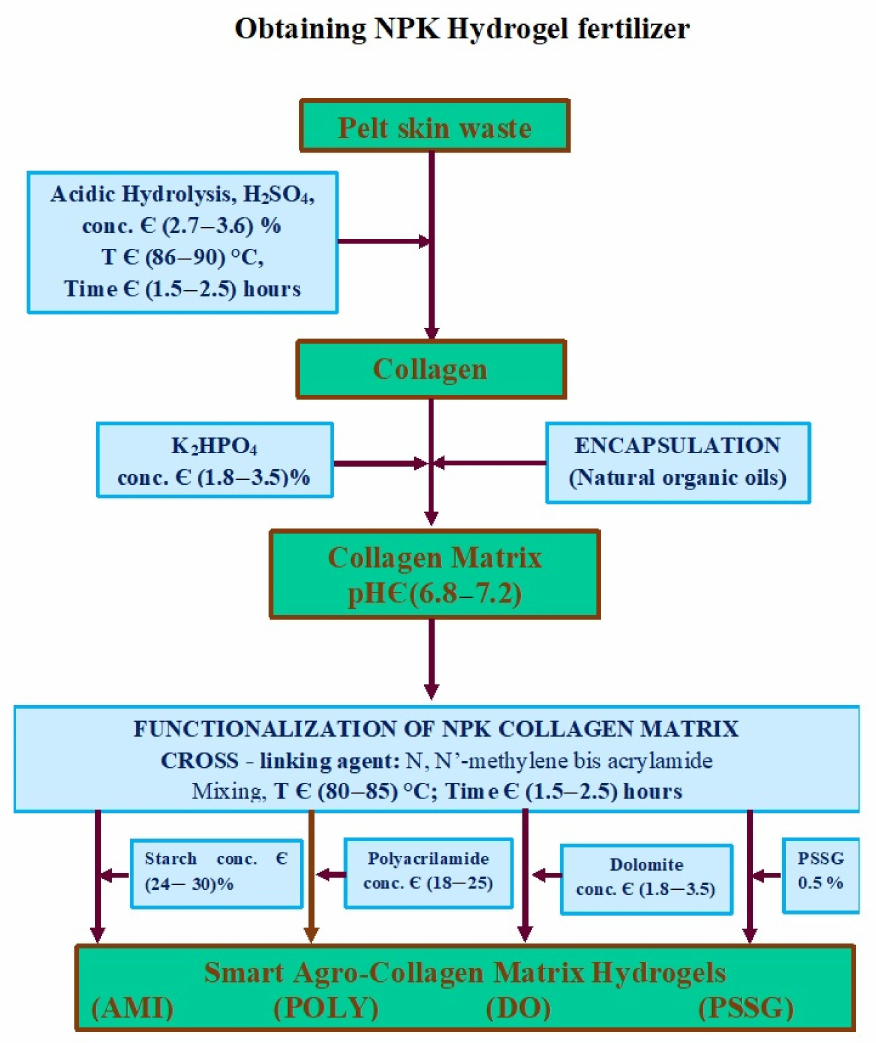
Figure 5. Technology scheme for obtaining smart-fertilizers by using acid hydrolysis,